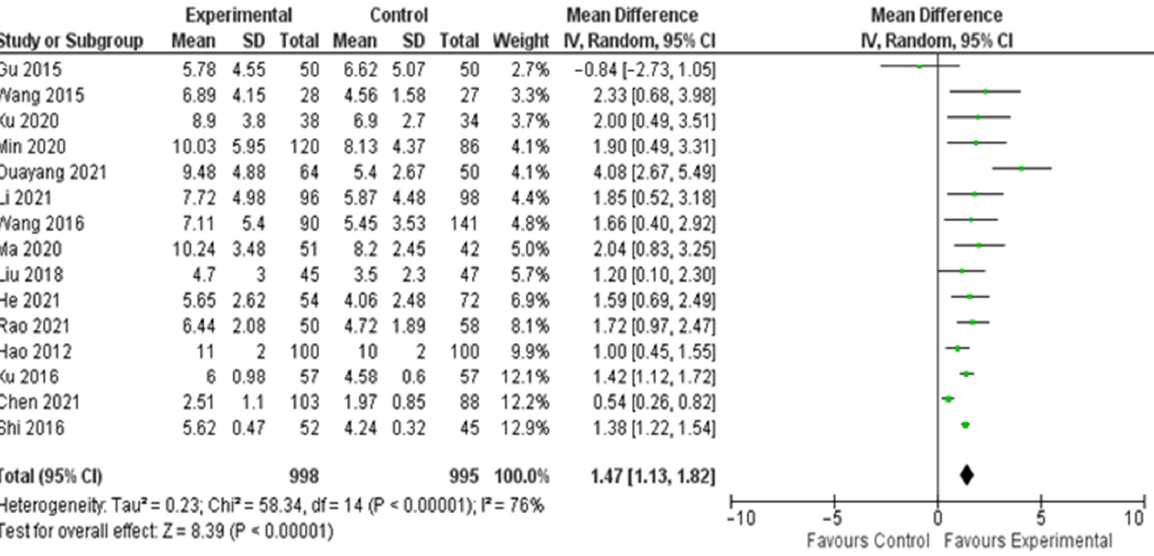
Figure 2. Forest plot of the total number of lymph nodes harvested.